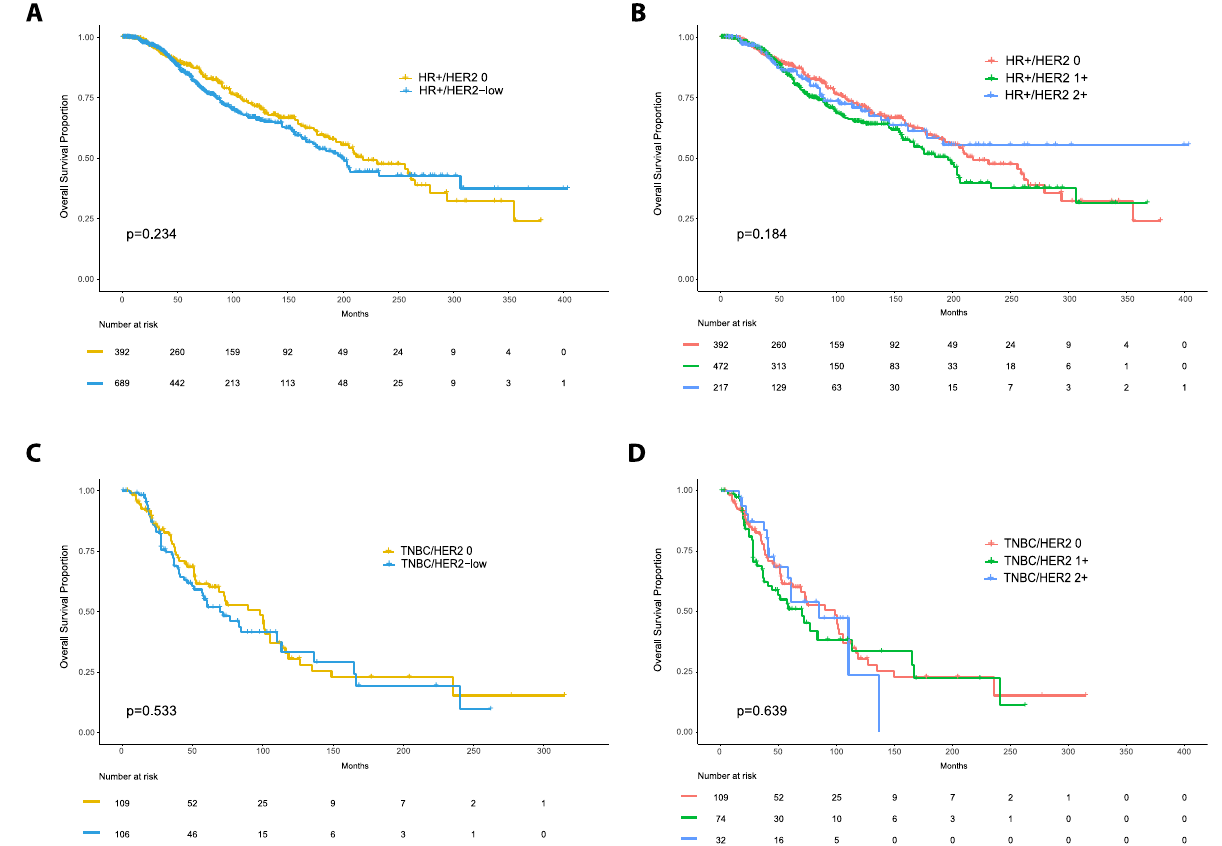
Fig. 6 Overall survival in patients with advanced HER2-negative breast cancer according to HER2 expression. The fi gure shows Kaplan – Meier curves of overall survival for HER2-low vs HER2 0 tumors in the HR-positive ( A ) and TNBC ( C ) populations, as well as OS curves for HER2 2 + vs. HER2 1 + vs. HER2 0 tumors for the HR-positive ( B ) and TNBC ( D ) populations with number at risk shown at the bottom of each box. p -values for log-rank tests are also reported; HR-positive hormone receptor positive, TNBC